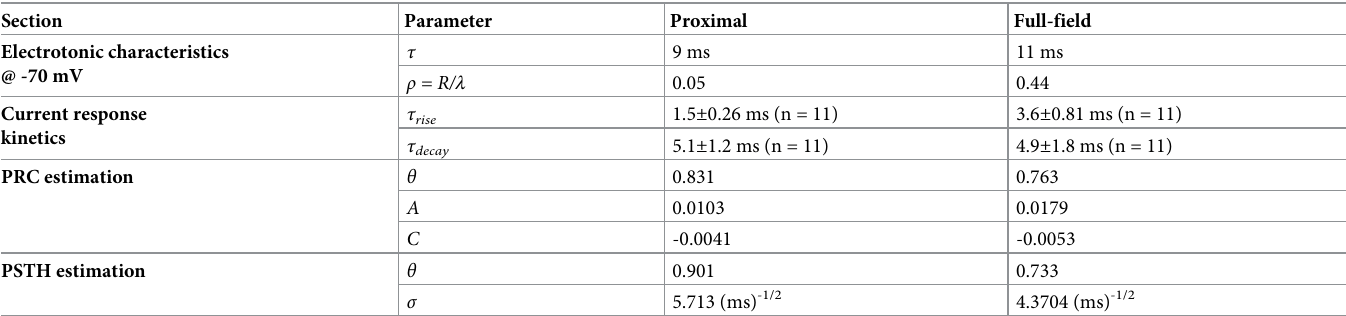
Table 1. Values of fitted